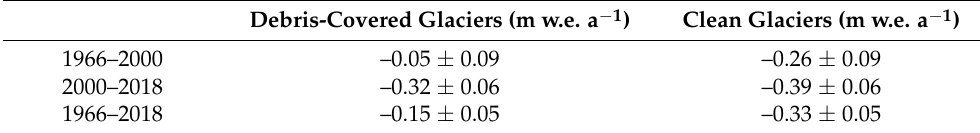
Figure 7. Debris cover of the glaciers in the A'nyêmaqên Mountains. CGI2 represents the outlines derived from the second Chinese Glacier Inventories (2009). ( A – C ) denote the Weigeledangxiong Glacier, the Halong Glacier, and the Yehelong Glacier, respectively. Table 4. Glacier mass balance changes in debris-covered and clean glaciers.